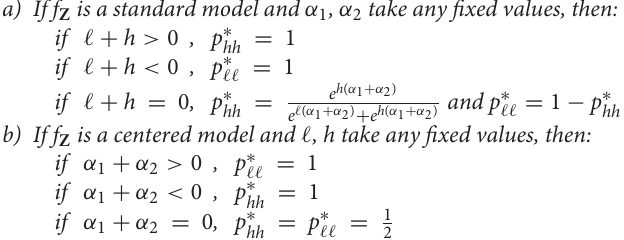
with graph and probability table as shown in Figure 2 . Let p ∗ p ∗ , and p ∗ be the limiting probabilities in the table as λ h ℓ hh